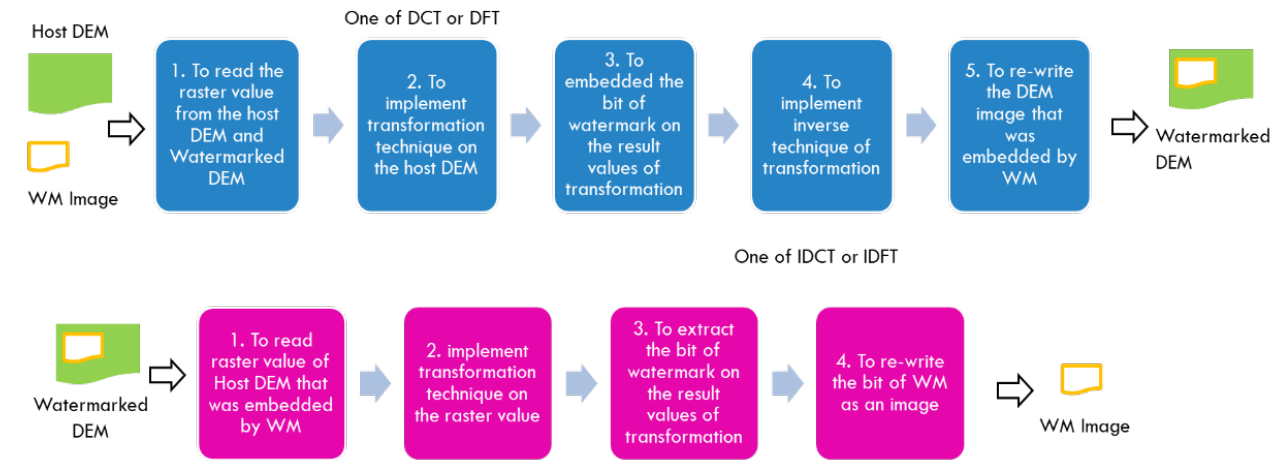
Figure 1. Construction of watermarking